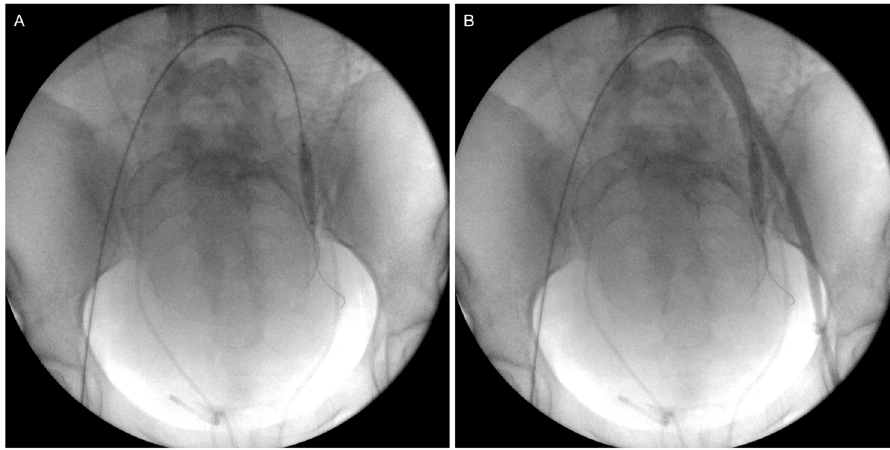
Figure 1 - Balloon catheter placement and testing. (A) Inflated balloon catheter positioned in the left internal iliac artery. (B) Retrograde contrast injection through the left femoral sheath confirming the correct placement of the balloon and the absence of flow distally into the internal iliac